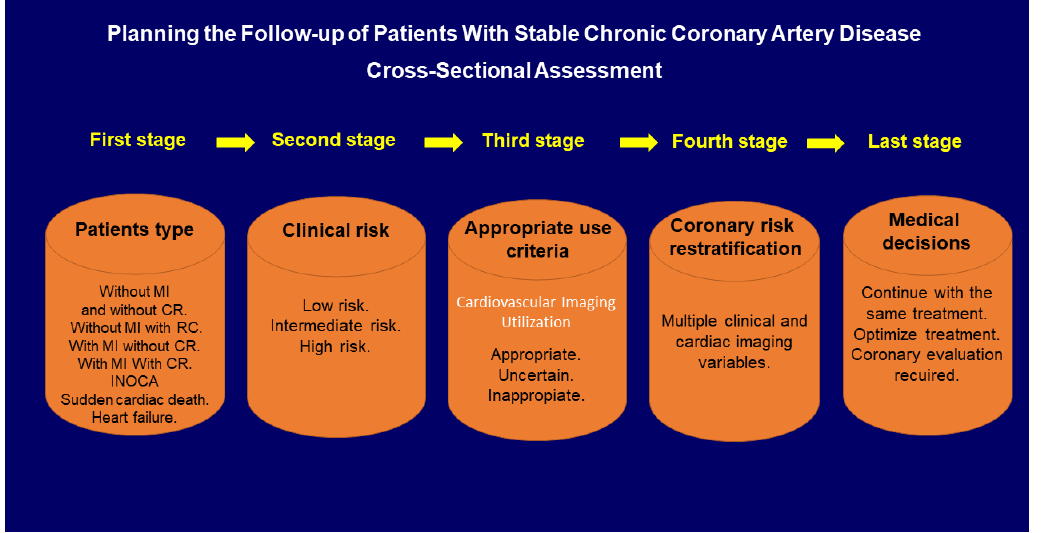
Figure 1. Cross-sectional assessment algorithm to evaluate patients with stable chronic coronary artery disease. Five-stage assessment. Every time that patients have a medical check-up during the follow-up, they require this cross-sectional assessment, although not all patients in the clinical practice setting need to be evaluated for all these steps. For example, if a patient during the follow-up continued to be low risk, there would be no need to continue with stages 3, 4 and 5.